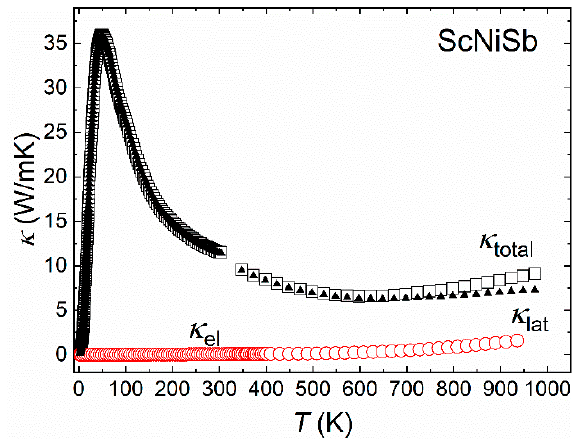
Figure 6. Temperature variation of the thermal conductivity in ScNiSb (squares). Estimates for the electron ( κ el ) and lattice contributions ( κ lat ) (see the text) are shown by red circles and black triangles, respectively.